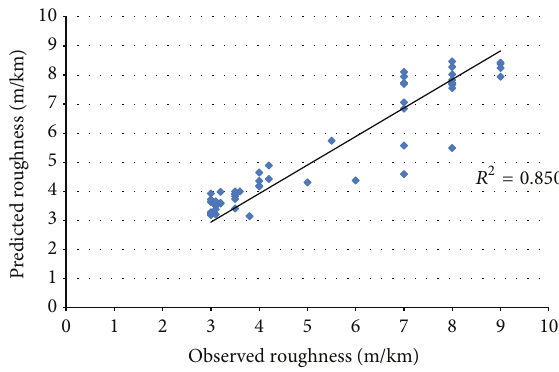
Figure 1: Comparison between predicted and observed roughness values based on the out of sample data.